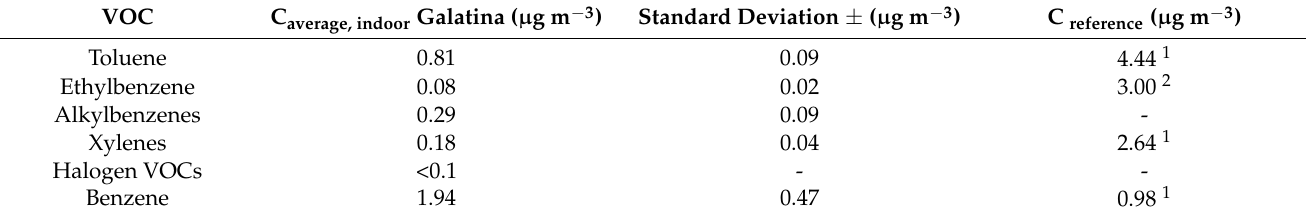
Table 2. Indoor average concentration and reference values for main VOCs investigated.